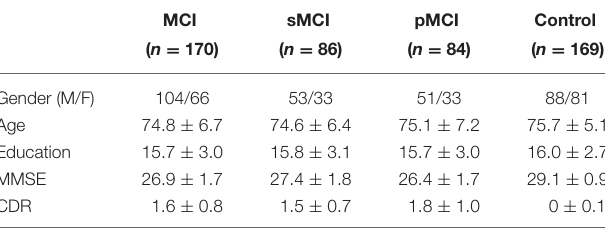
TABLE 1 | Subject demographic and clinical